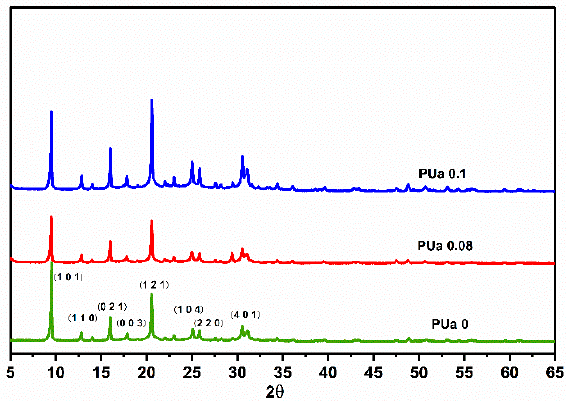
Figure 4. XRD patterns of the as-synthesized SAPO-34 samples with and without PUa as mesoporogen.